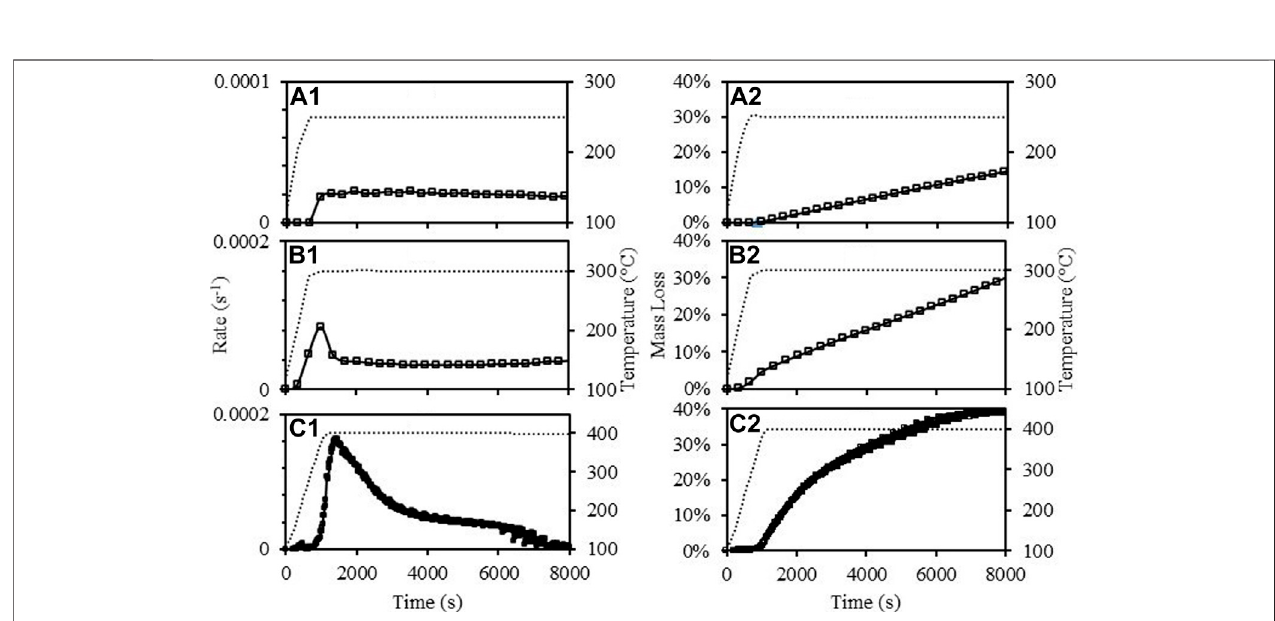
FIGURE 4 | Mass loss rate of MPW torrefaction at: 250 ° C (a1) , 300 ° C (b1) , 400 ° C (c1) ; mass loss of paper torrefaction at: 250 ° C (a2) , 300 ° C (b2) , 400 ° C (c2) .